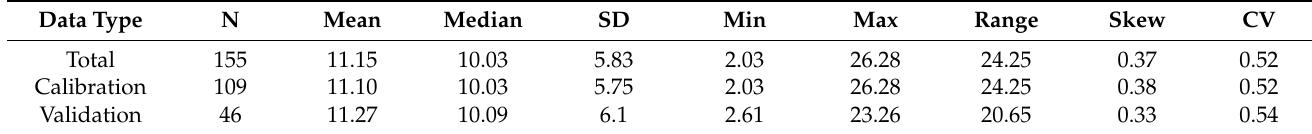
Table 1. Descriptive analysis of SOC (g/kg) in the study